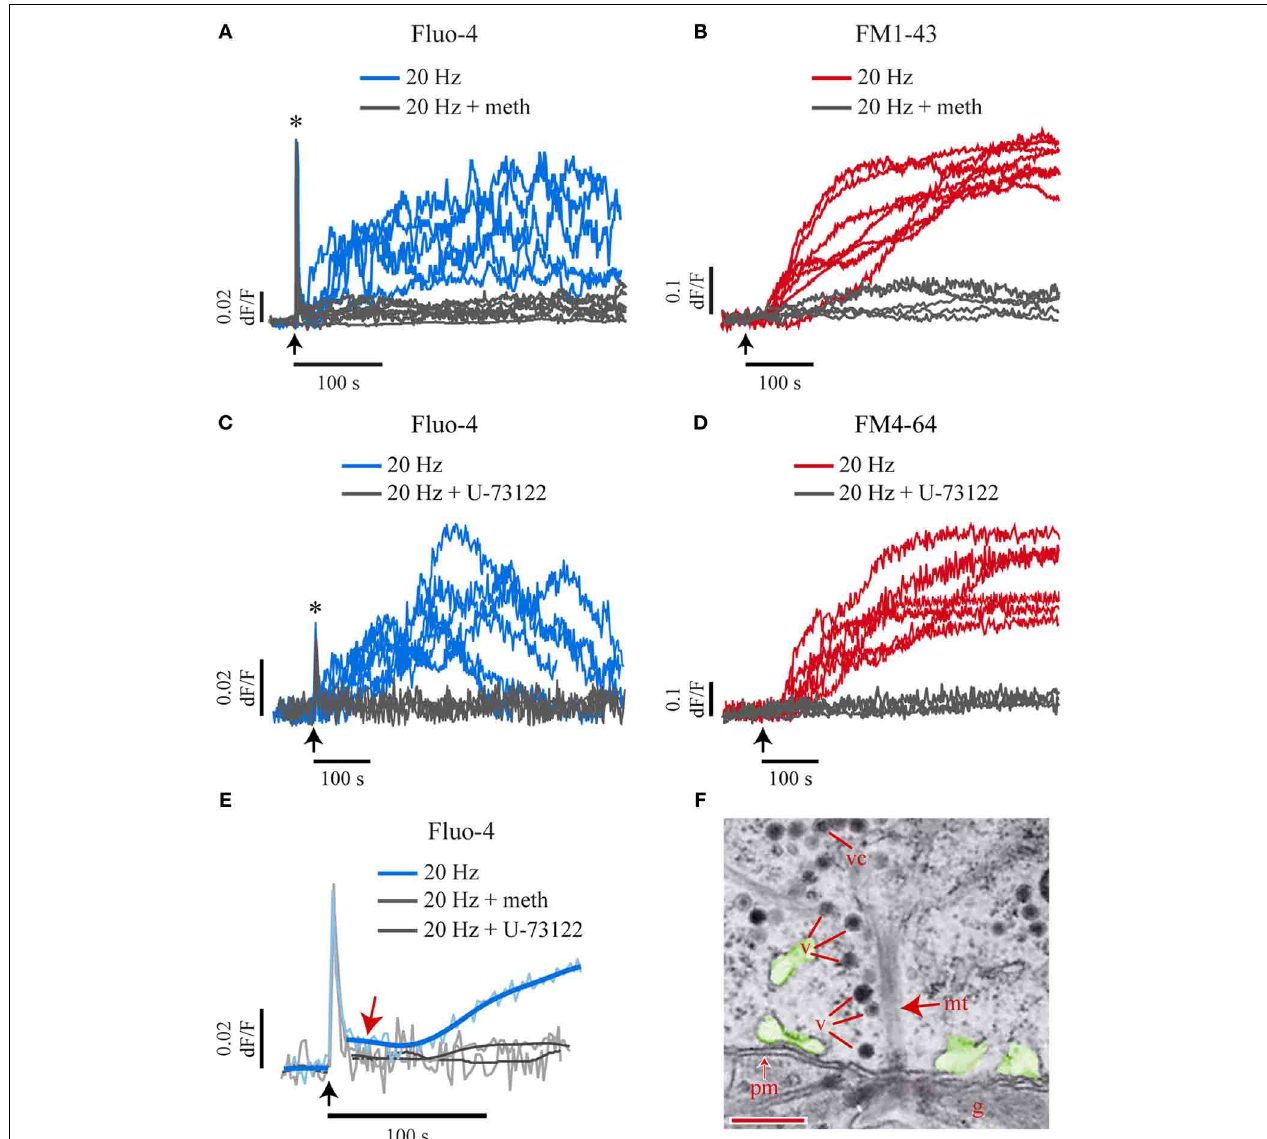
(which appears truncated due to the 0.5-Hz imaging sampling rate; asterisk). Exocytosis and Ca 2 + increases were measured simultaneously under confocal conditions. (E) Blockade of 5-HT receptors or PLC (gray traces) also abolished the small Ca 2 + transient (blue trace, red arrow). The pale blue traces are an average of the Ca 2 + kinetics obtained from seven neurons. Smoothed traces are superimposed in darker blue. (F) Electronmicrograph showing dense core vesicles (v) aligned to the microtubule bundles (mt) arriving at the plasma membrane (pm) of a soma that was fixed after 1-Hz stimulation. Exocytosis from these vesicles may release the 5-HT that produces the small Ca 2 + transient. The endoplasmic reticulum, possible intracellular Ca 2 + source is pseudocolored in green. The glia is marked as “g.” Scale bar =